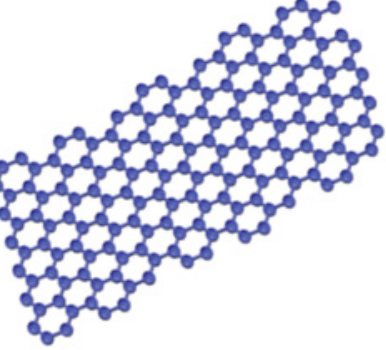
Figure 1. Structure of graphene nanosheet.